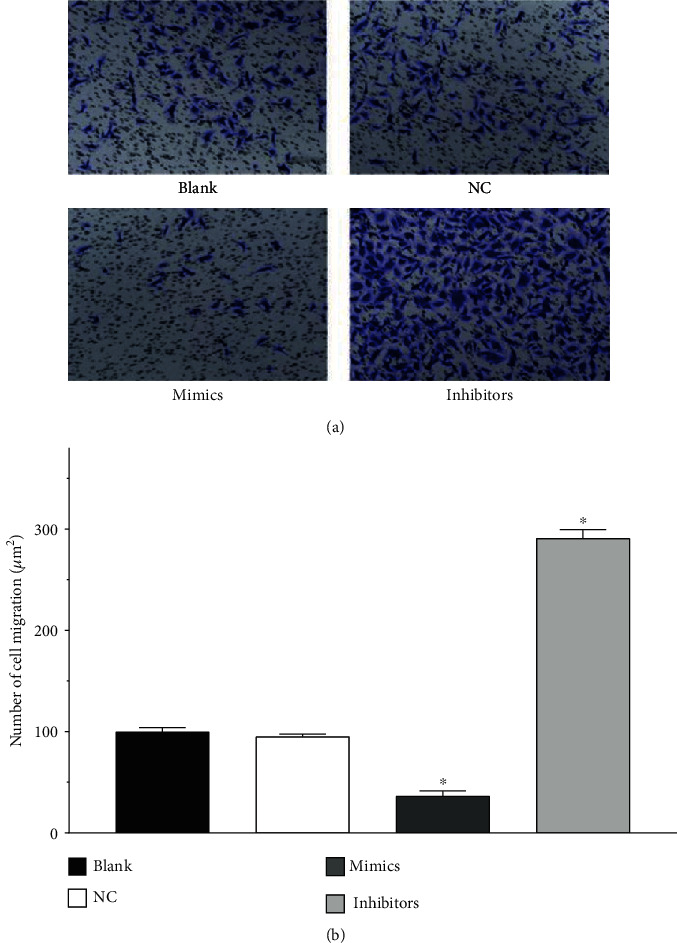
Effects of transfected miR-499a-3p on the migration of primary HUVECs revealed by Transwell tests. (a) Visual field (magnitude: 100x) of equal area was randomly chosen and schematically presented for each group, including blank, NC, mimics, and inhibitors groups. (b) The average number of cells counted in the visual field randomly chosen in each group (n = 3).